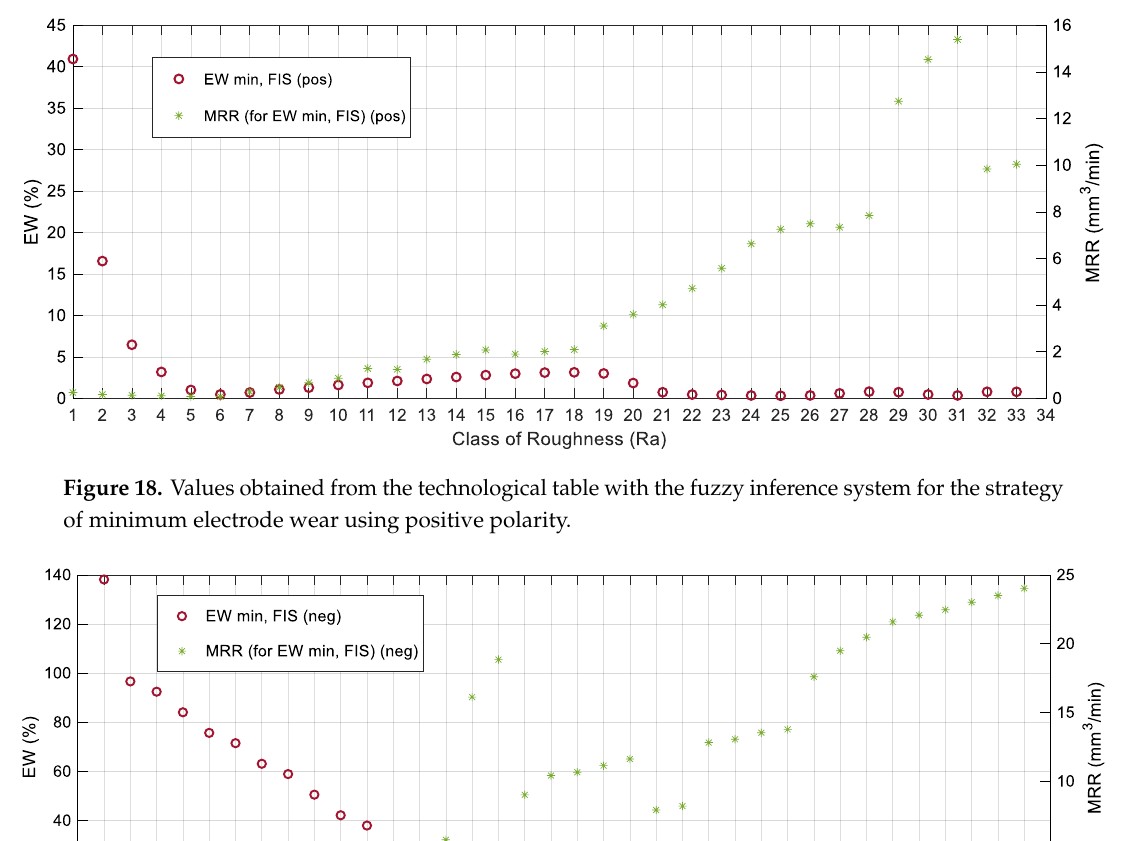
Figure 17. Values obtained from the technological table with the fuzzy inference system for the strategy of maximum removal rate using negative polarity. Mathematics 2020 , 8 , x 22 of 26